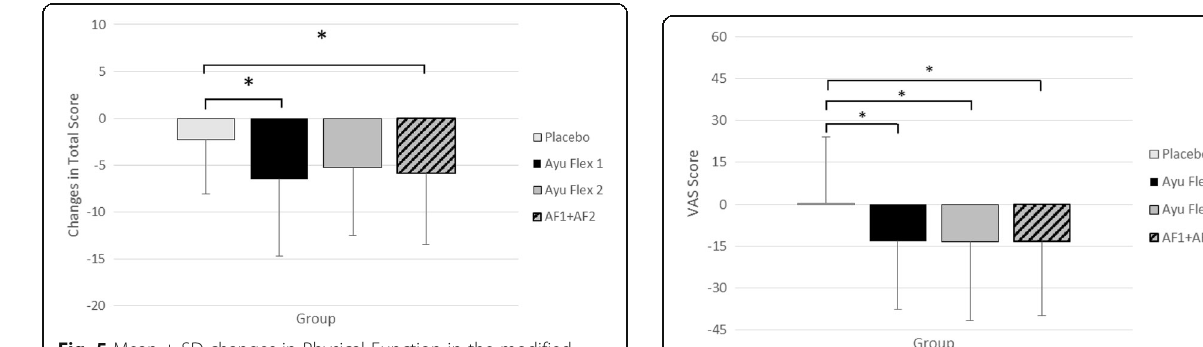
Fig. 5 Mean ± SD changes in Physical Function in the modified WOMAC score subscale. Significant differences were noted between the AF1 Group ( p = 0.039) and the combined Active Groups ( p = 0.046) vs. the Placebo Group